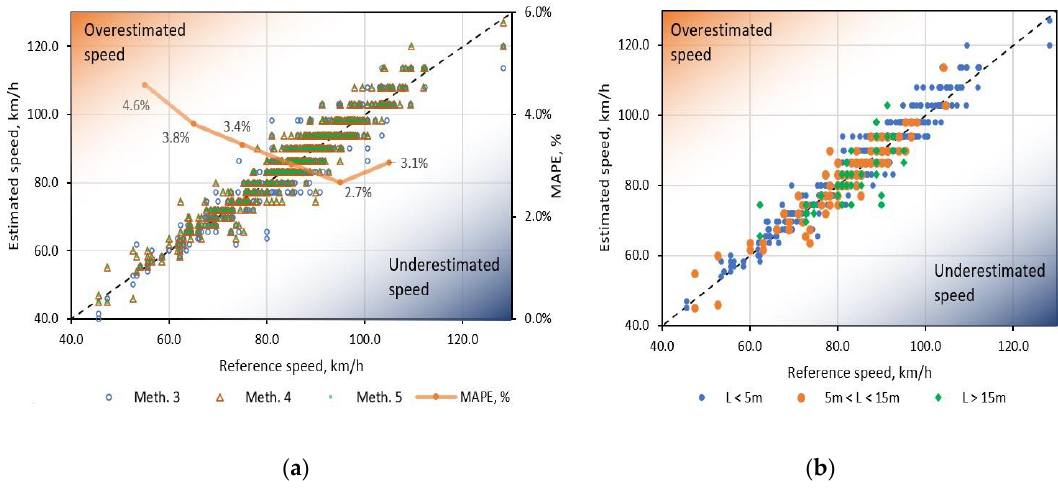
Figure 9. ( a ) Speed estimation performances of methods (1, 2, 3) and MAPE versus reference speed from the PVDF sensors. ( b ) Speed estimation performances with method 3 versus three di ff erent vehicle length groups (L < 5 m, 5 m < L < 15 m, and L > 15 m). Table 3. Accuracy enhancement technique performances with three di ff erent speed estimation methods and di ff erent speed groups. MAPE, mean absolute percentage